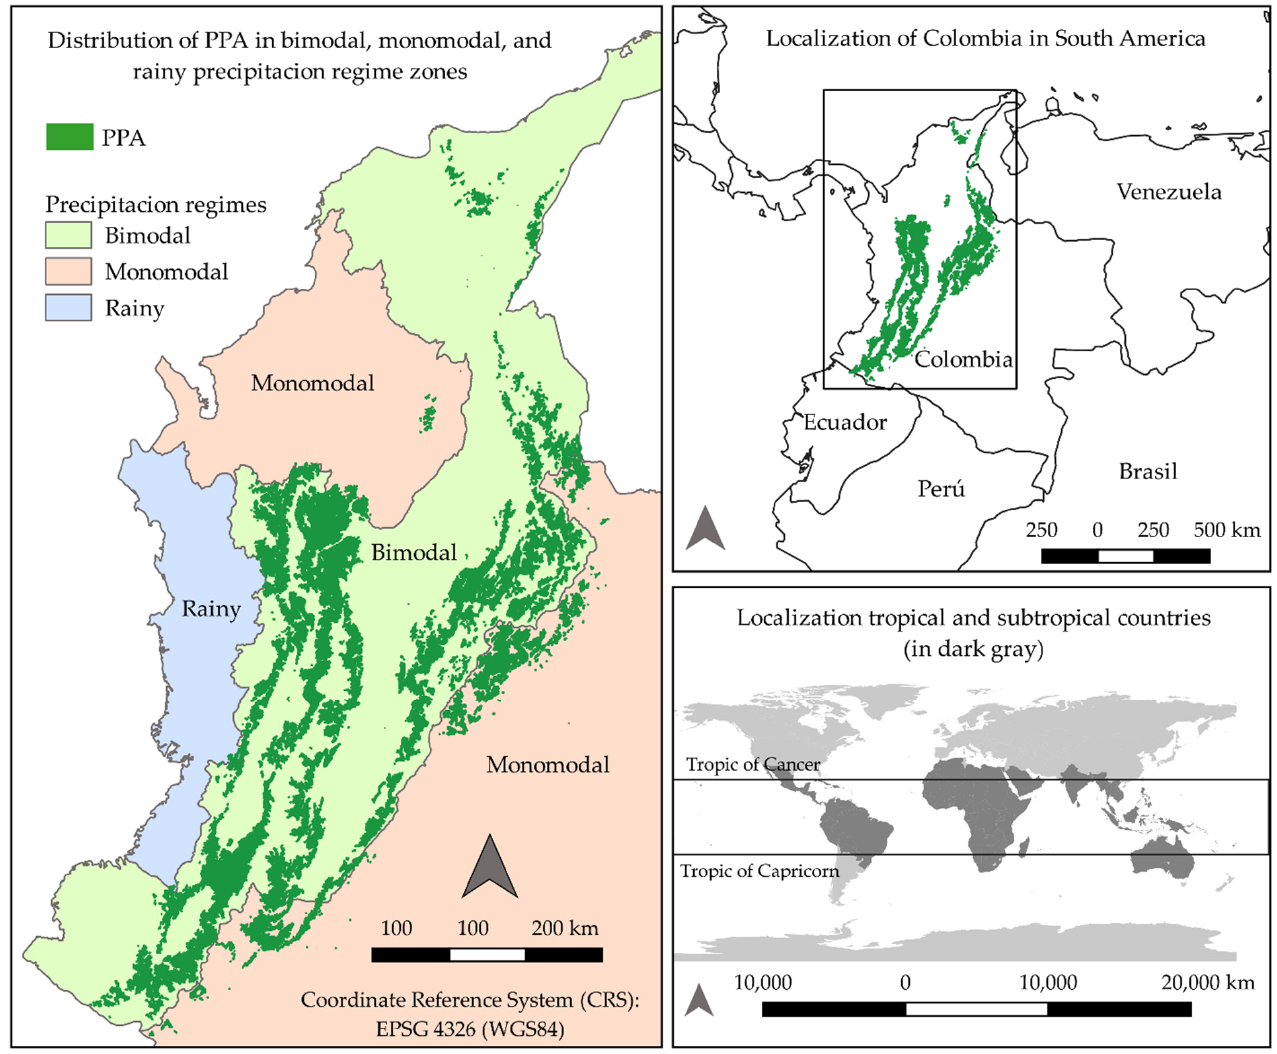
Figure 1. Distribution of Colombia’s current and potential Hass avocado production zones (PPA), according to precipitation regimes zones.